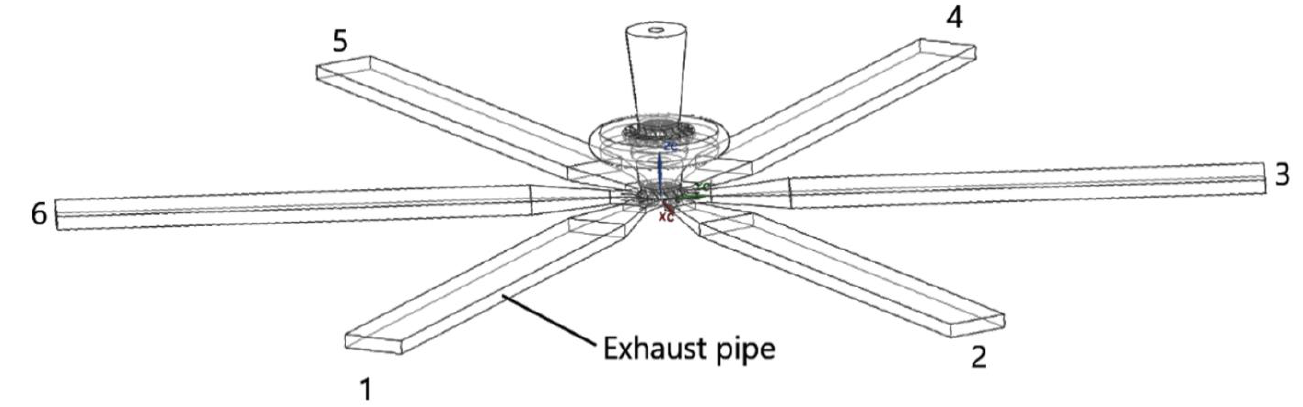
Figure 5. The configuration of the turbine inlet with the six exhaust pipes